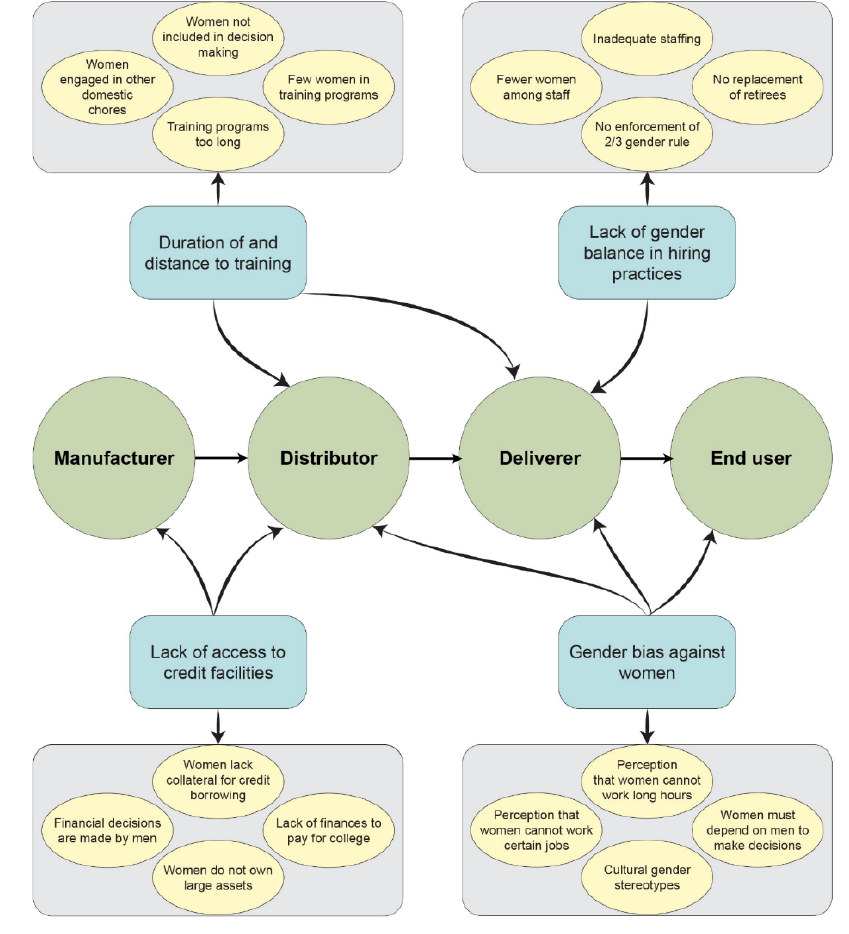
Figure 3. Barriers specific to women at different modes of the LVVC.